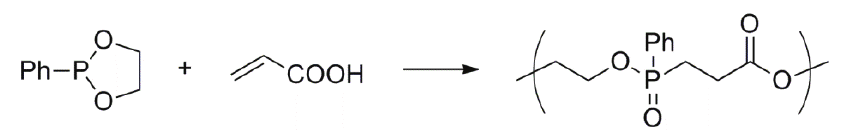
Figure 63. Intermolecular reduction-oxidation during the alternating copolymerization of a cyclic phosphorus (III) monomer with acrylic acid.